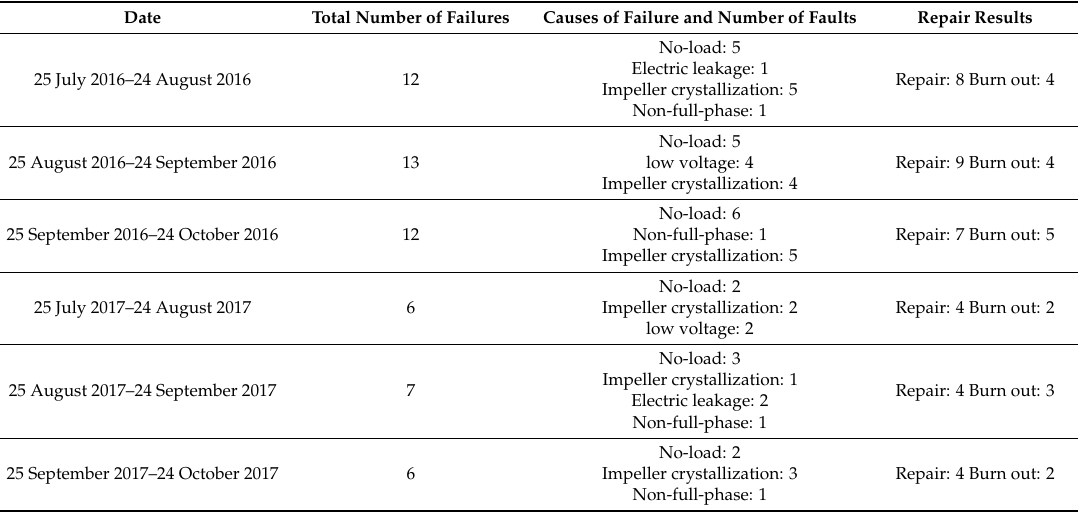
Table 11. Fault analysis of brine pump before and after system